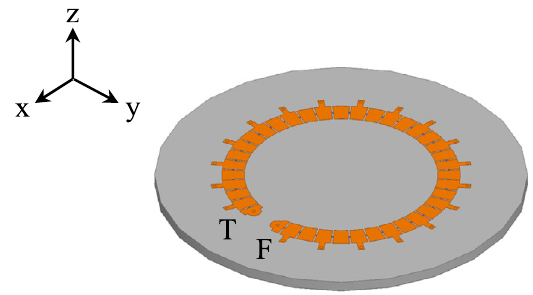
Fig. 14. Round metaloop-N antenna (RND-MTLP-N), made by curving the N-type metaline shown in Figure 2b, where N cell = 19.